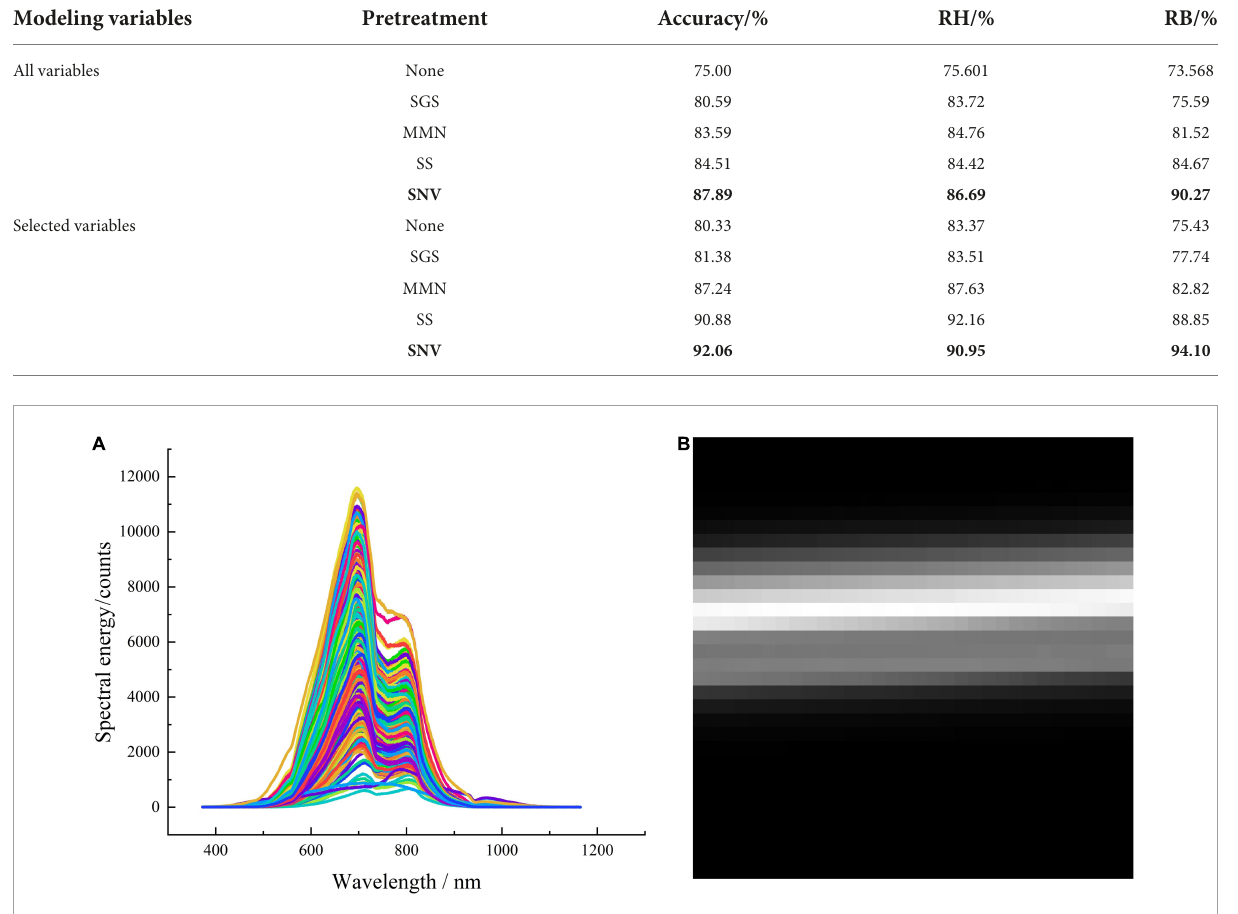
FIGURE9 Original spectra of Yali pears and the transformed two-dimensional spectral image (A) original spectra, (B) two-dimensional spectral